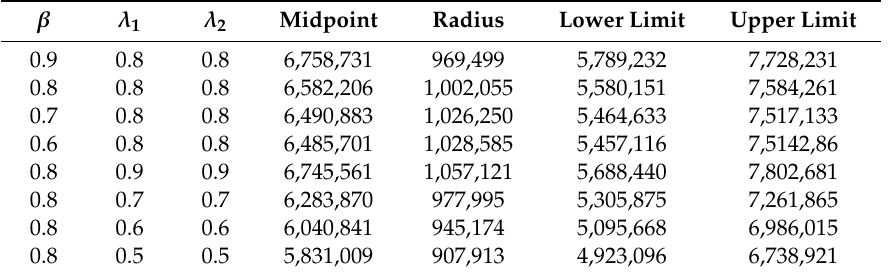
Table 3. Interval of total annual cost with di ff erent weighting coe ffi cients and probability degrees